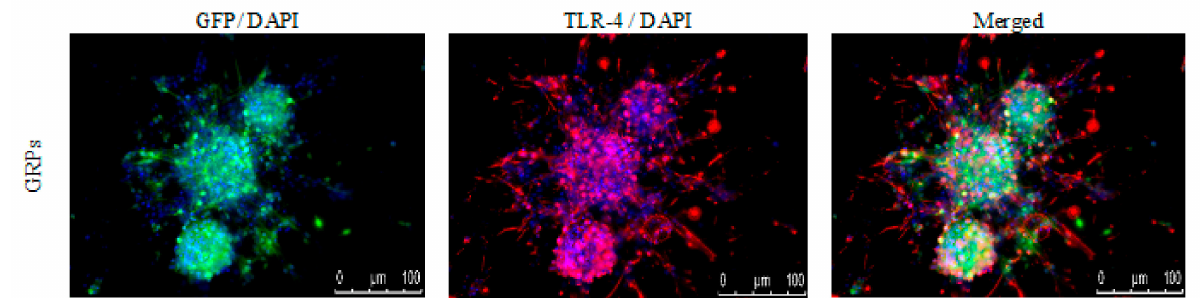
Figure 2. Mouse GRPs’ expression of toll-like receptor-4 (TLR-4): The immunofluorescent (IF) staining of TLR-4 revealed that murine GRP is characterized by strong expression of TLR-4 receptor, which may lead to intensification of co-stimulatory molecules expression. Abbreviations: GRP-glial-restricted progenitor